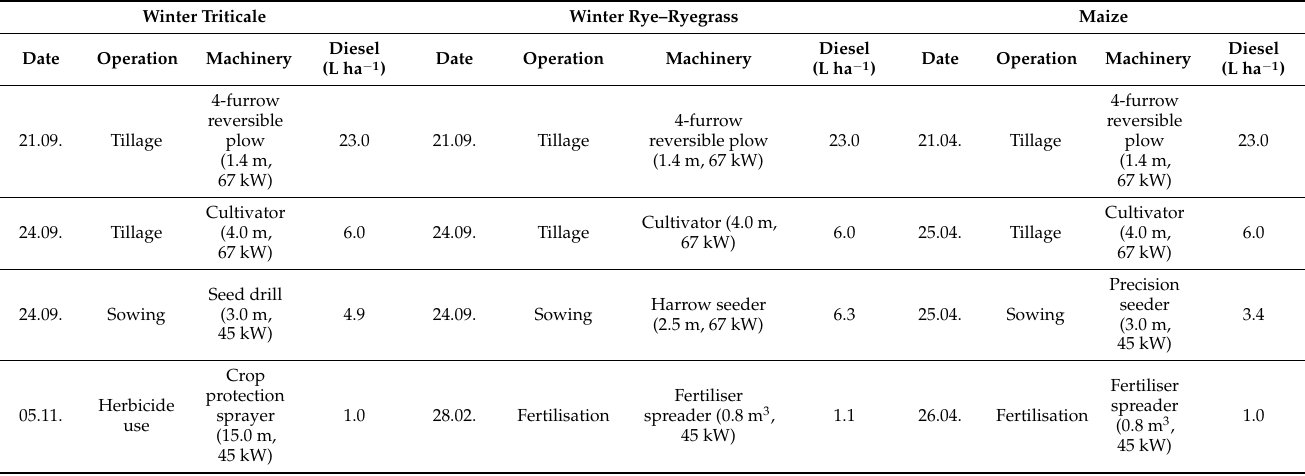
Table A4. Field operation data of winter triticale, winter rye with undersown ryegrass and maize at the Freising site in the experimental year 2006/07. Values for diesel consumption adjusted for farm-to-field distance (2 km) and transported